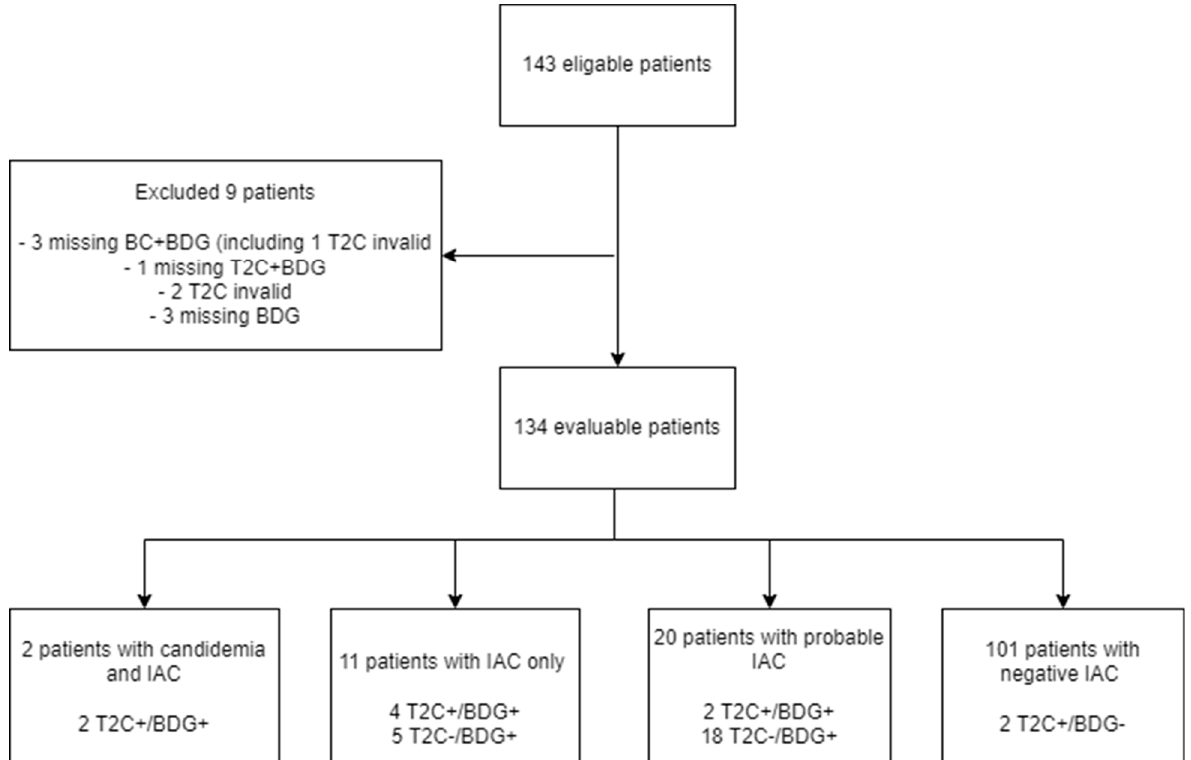
Figure 1. Flowchart of patient inclusion. Abbreviations: T2C, T2Candida magnetic resonance assay; BDG, 1,3- β -D-glucan; IAC, intraabdominal candidiasis . Table 2. Baseline characteristics, n =